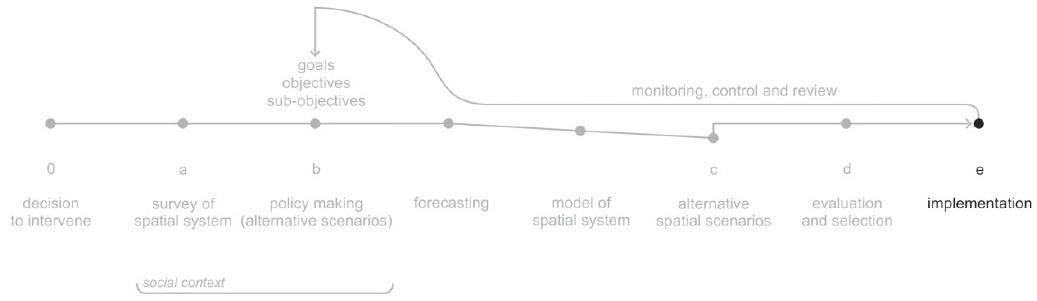
Figure 4. The exclusive emphasis on implementation, according to Friedmann’s [12] action-centred land-use planning model, with the comprehensive model’s components in the background. Gray circle: lack of the corresponding McLoughlin component. Dark circle: the central component.